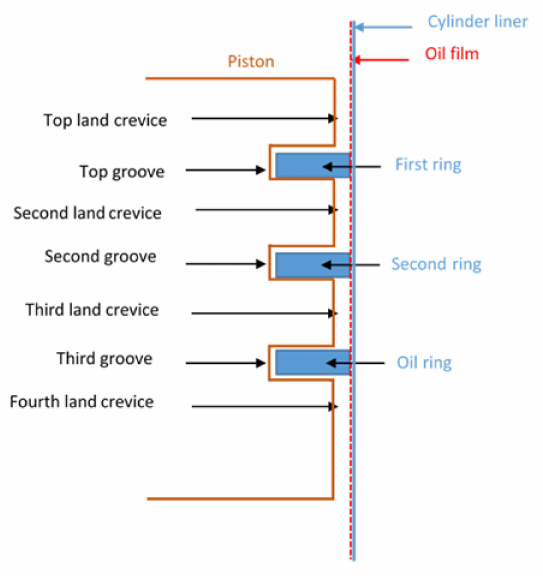
Figure 1. Ring positions on an engine